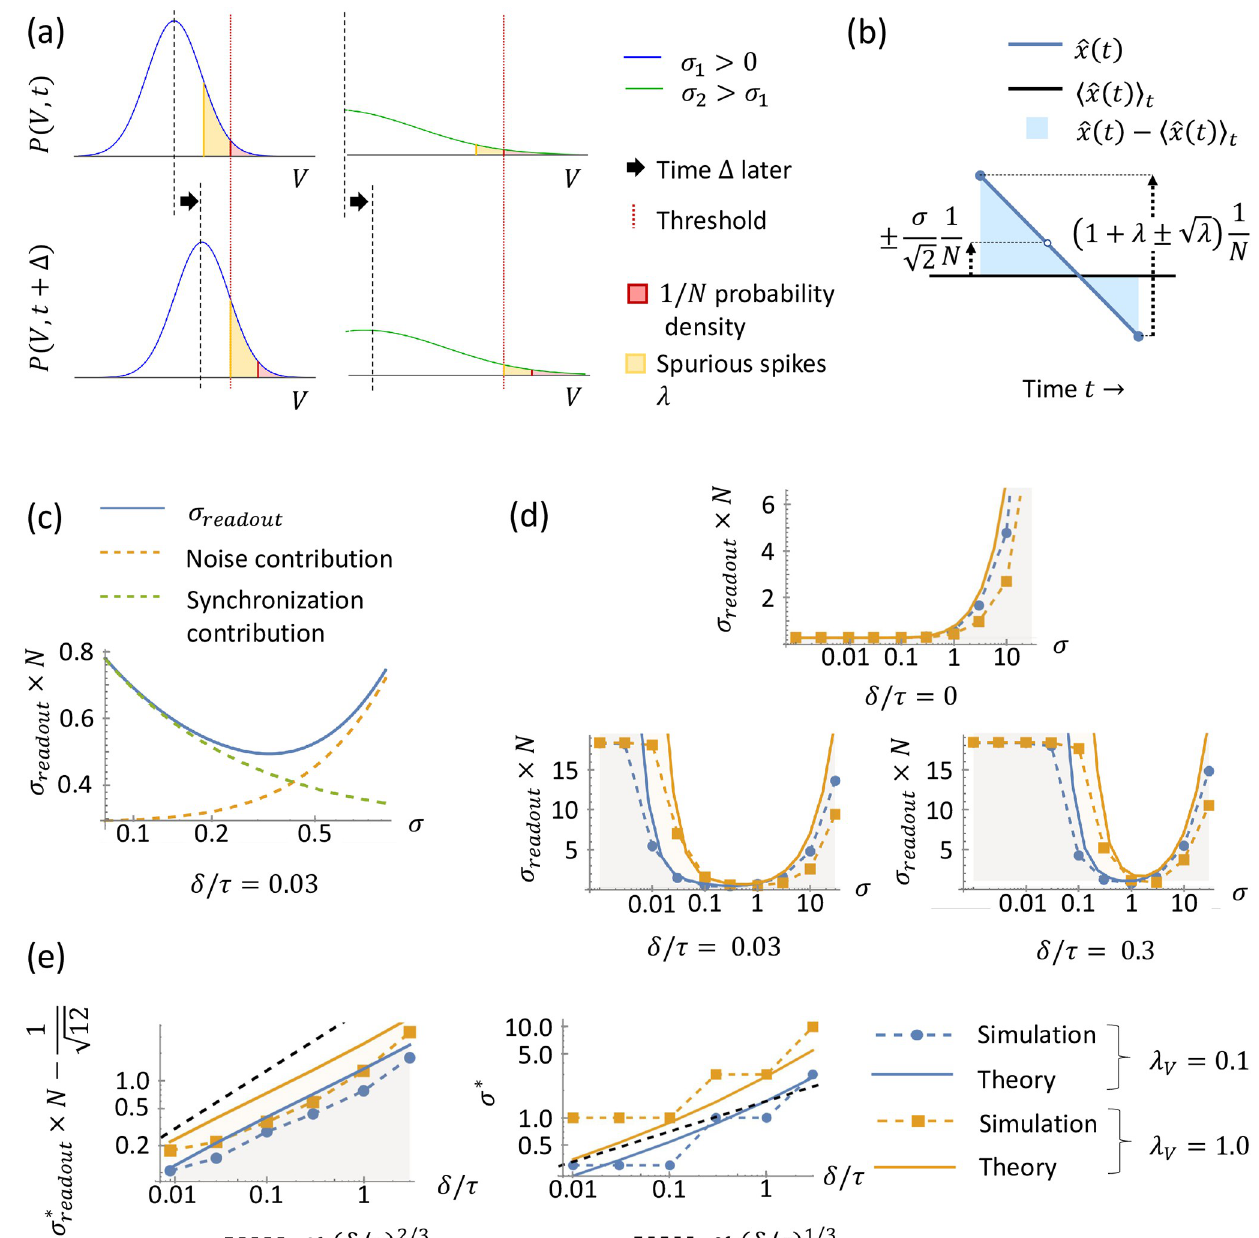
Fig 4. LIF model with nonzero delay. (a) Calculation of the number of spurious spikes. For a nonzero noise level σ 1 , the membrane potentials travel in a Gaussian packet with density P ( V , t ) (blue, top left) toward threshold (vertical red dotted line). The typical position of the packet at the time t when the first neuron spikes is determined by ensuring the tail probability (red, shaded area) above threshold equals 1/ N . During the spike propagation delay Δ , the Gaussian packet continues traveling toward threshold (blue, bottom left), and the mean number of spurious spikes λ is given by the additional probability density that crosses threshold (yellow, shaded area). A larger noise level σ 2 spreads out the Gaussian packet (green, right), thus reducing λ . (b) Readout ^ x ð t Þ (blue) and its deviation ^ x ð t Þ (cid:0) x ð t Þ (light blue shaded) from the mean h ^ x ð t Þi . Similar to Fig 3b, the accumulated spike-time variation creates fluctuations in t ^ x ð t Þ with standard deviation upper-bounded by s ffiffi , but in addition, spurious spikes introduce a Poisson variation in the readout with standard deviation p 1 2 ffiffiffi p N 1 l . (c) Integrating the deviations illustrated in (b) yields an approximate upper-bound for σ readout , Eq 24 (blue). Conceptually, σ readout receives N contributions from noise (Eq 24 without the λ term; yellow, dashed), and synchronous spurious spikes (Eq 24 without the s 2 term; green, dashed). (d) 2 Readout error σ readout for varying levels of noise. For zero delay (top), noise is not necessary to prevent spurious spikes, and thus it strictly increases σ readout . For non-zero delays (bottom), σ has a U-shaped dependence on σ , and an optimal noise level σ � exists. The dots/squares on dashed lines represent readout σ readout from simulations ( N = 64), and solid lines are Eq 24, with the region below shaded, indicating upper-bound. Blue signifies λ V = 0.1; yellow λ V = 1.0.